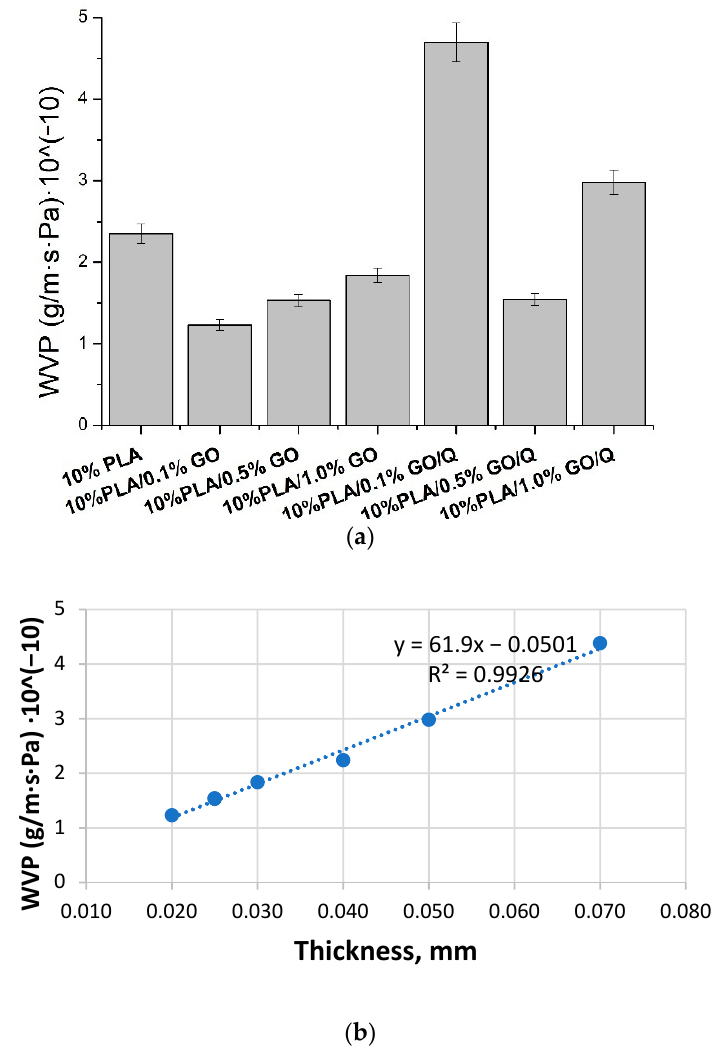
Figure 6. WVP of the PLA membranes ( a ) and WVP versus thickness plotting ( b ). Table 3. Water vapor permeation through the membranes for the samples correlated with the average thickness of the membranes.